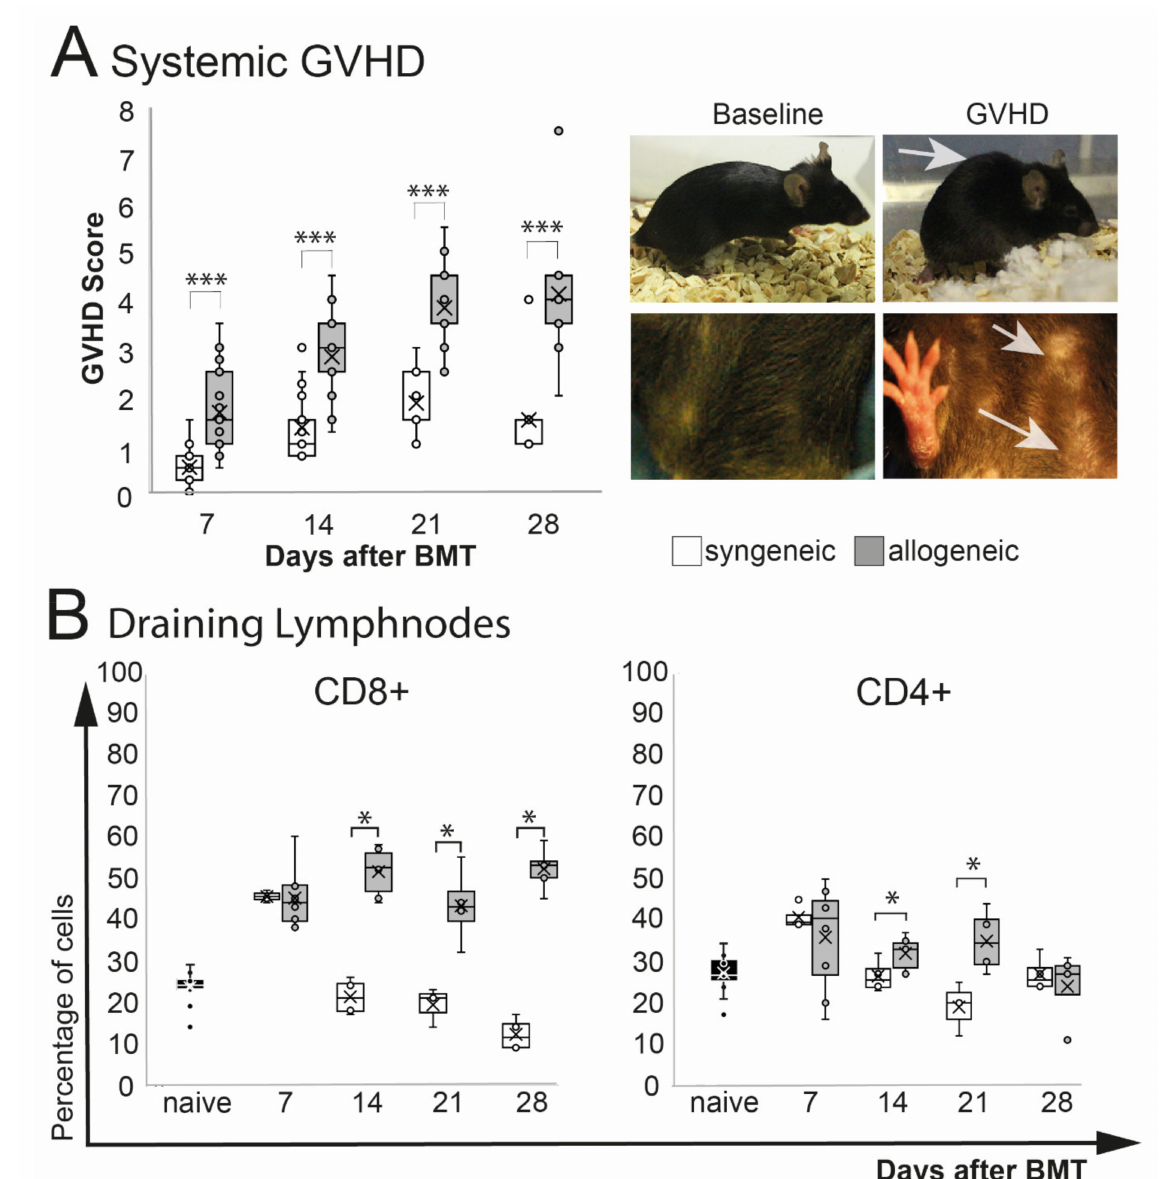
Figure 1. Systemic phenotype after chemotherapy and either syngeneic (B6-B6) or allogeneic (129s/B6) BMT, respectively. GVHD score contained weight loss, fur and skin condition, posture, and overall activity. ( A ) Allogeneic transplanted mice demonstrated a significant GVHD burden. Exemplary macroscopic images showing typical hunched back (upper right photo) and scaled skin of allogeneic GVHD mice (lower right photo; see arrows) compared to baseline. ( B ) Flow cytometry analysis of eye-draining lymph nodes. Compared to syngeneic controls allogeneic mice showed a significantly higher percentage of CD8+ T cells and CD4+ T cells from day 14 after BMT. (* p ≤ 0.05, *** p <